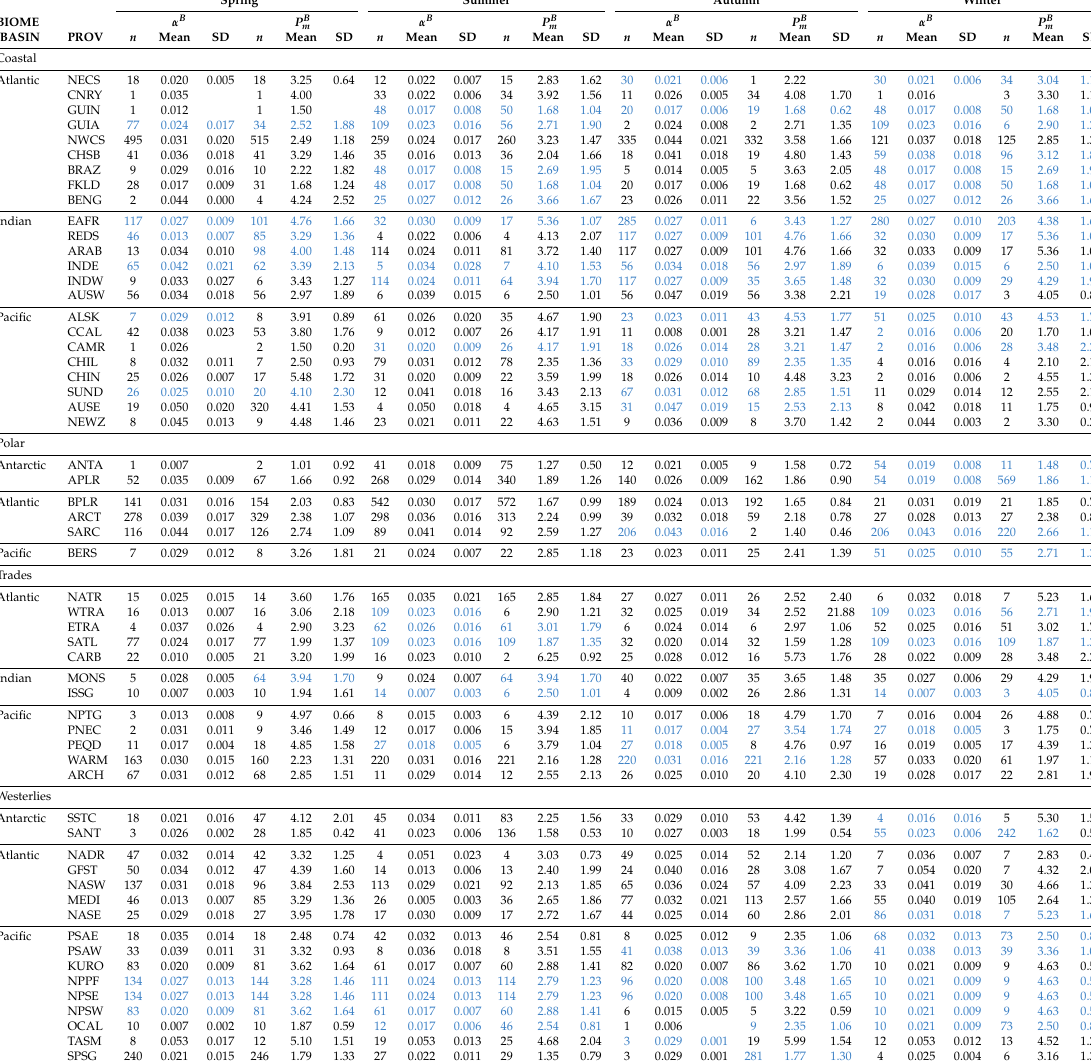
Table 1. Sample size ( n ), mean and standard deviation (SD) of the initial slope ( α B in mg C mg Chl-a − 1 h − 1 ( µ mol photons m − 2 s − 1 ) − 1 ) and the assimilation number ( P B m in mg C mg Chl-a − 1 h − 1 ) of the photosynthesis versus irradiance (P-I) curve for each biogeographic province and season. Values in blue are obtained from statistical comparisons between seasons and biogeographic provinces, while other values are directly obtained from the P-I database. Biogeographic provinces are listed in Appendix